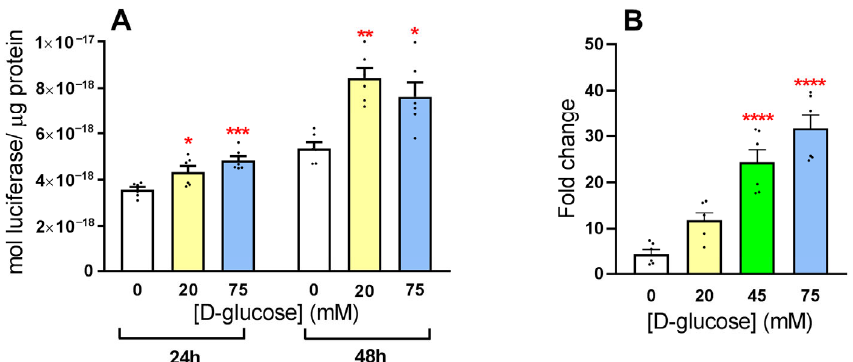
Figure 3. High glucose treatment induced an inflammatory response in HLE cells. HLE cells were grown in MEM (see Section 2.2) supplemented with the indicated D-glucose concentrations. Values are reported as the mean ± SEM of six independent measurements. Statistical analysis was performed using one-way ANOVA with Tukey post hoc test. Significance was evaluated with respect to untreated cells (*: p < 0.05; **: p < 0.01; ***: p < 0.001; ****: p < 0.0001). ( A ) The expression of NF- κ B was measured at the indicated times, through luminometric detection (see Section 2.4) and reported as mol of luciferase/ µ g of protein. ( B ) The expression of COX-2 was measured through Western blot (see Section 2.7), 48 h after the addition of glucose. For each condition, data are reported as fold change with respect to COX ‐ 2 expression, measured at time zero of incubation.